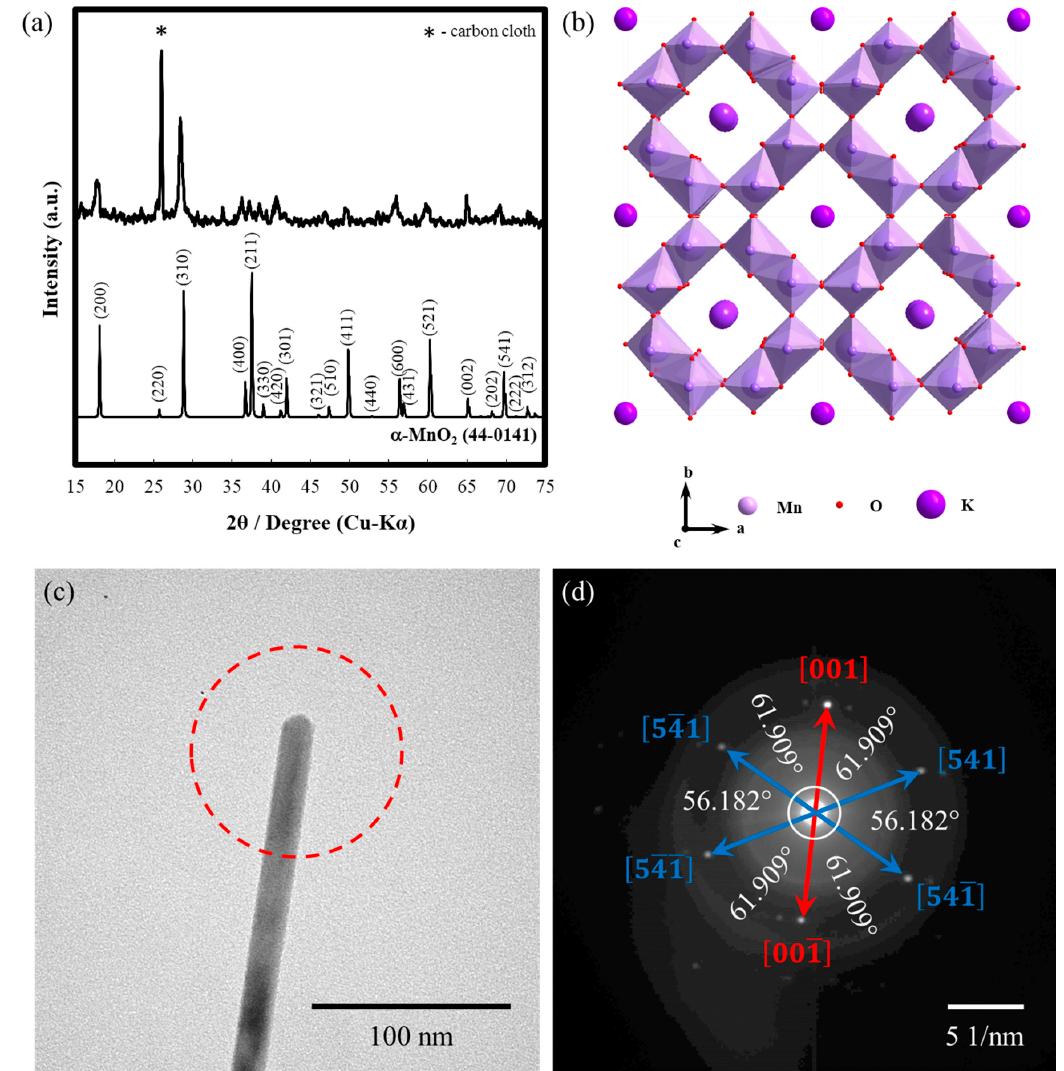
Figure 2. ( a ) XRD pattern of synthesized binder-free single crystal α -MnO 2 nanowire-carbon fiber composite cathode, ( b ) simulated structure, ( c ) TEM image, and ( d ) SAED analysis of single crystal α -MnO 2 .